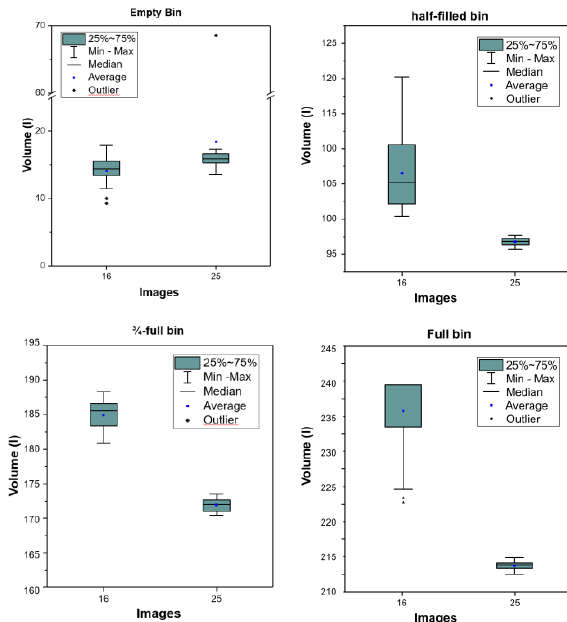
Figure 9: Reliability tests of volume measurements at different filling levels (empty, half-full, ¾ full and full), n = 20 For the half-filled bin (Figure 9, top right), the variation of the computed volume is very small when using 25 images. In contrast, the volume values for the use of 16 images are very